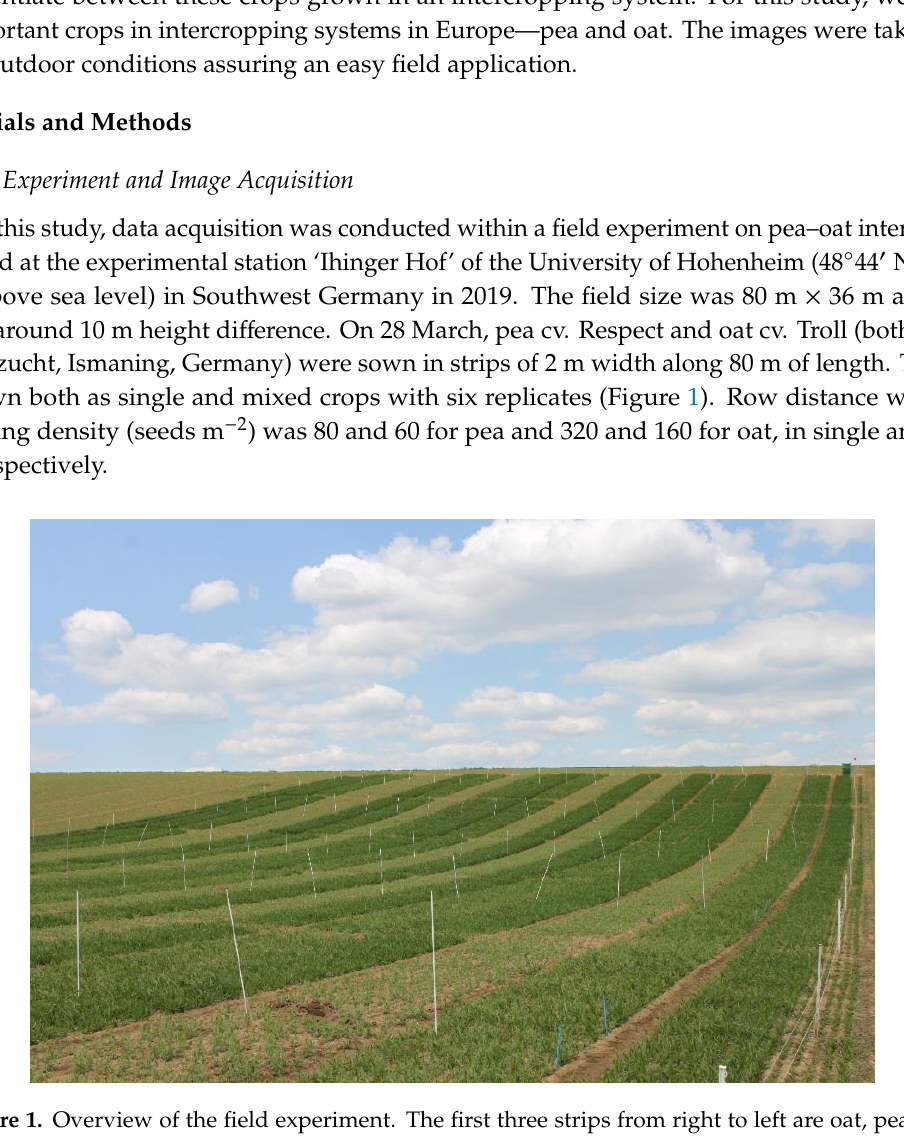
Figure 1. Overview of the field experiment. The first three strips from right to left are oat, pea–oat intercrop, and pea.